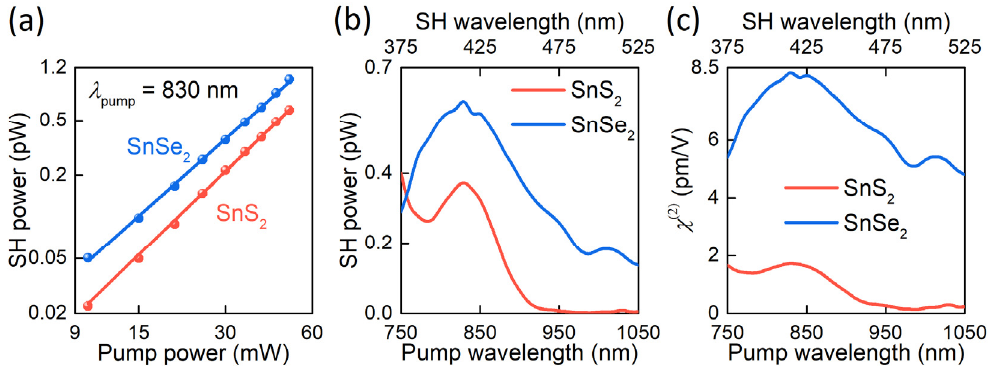
Figure 5. Nonlinear optical properties of SnS 2 and SnSe 2 . ( a ) Power-dependent nonlinear optical response of SnS 2 and SnSe 2 thin films, plotted in double logarithmic scale, and its linear approximation with slope p = 2.01 ± 0.02 for SnS 2 and p = 2.02 ± 0.04 for SnSe 2 . Pump wavelength is 830 nm. ( b ) SHG spectroscopy of SnS 2 (red line) and SnSe 2 (blue line) thin films at 40 mW pump power. ( c ) Wavelength-dependent, second-order, nonlinear optical susceptibility of SnS 2 (red line) and SnSe 2 (blue line).